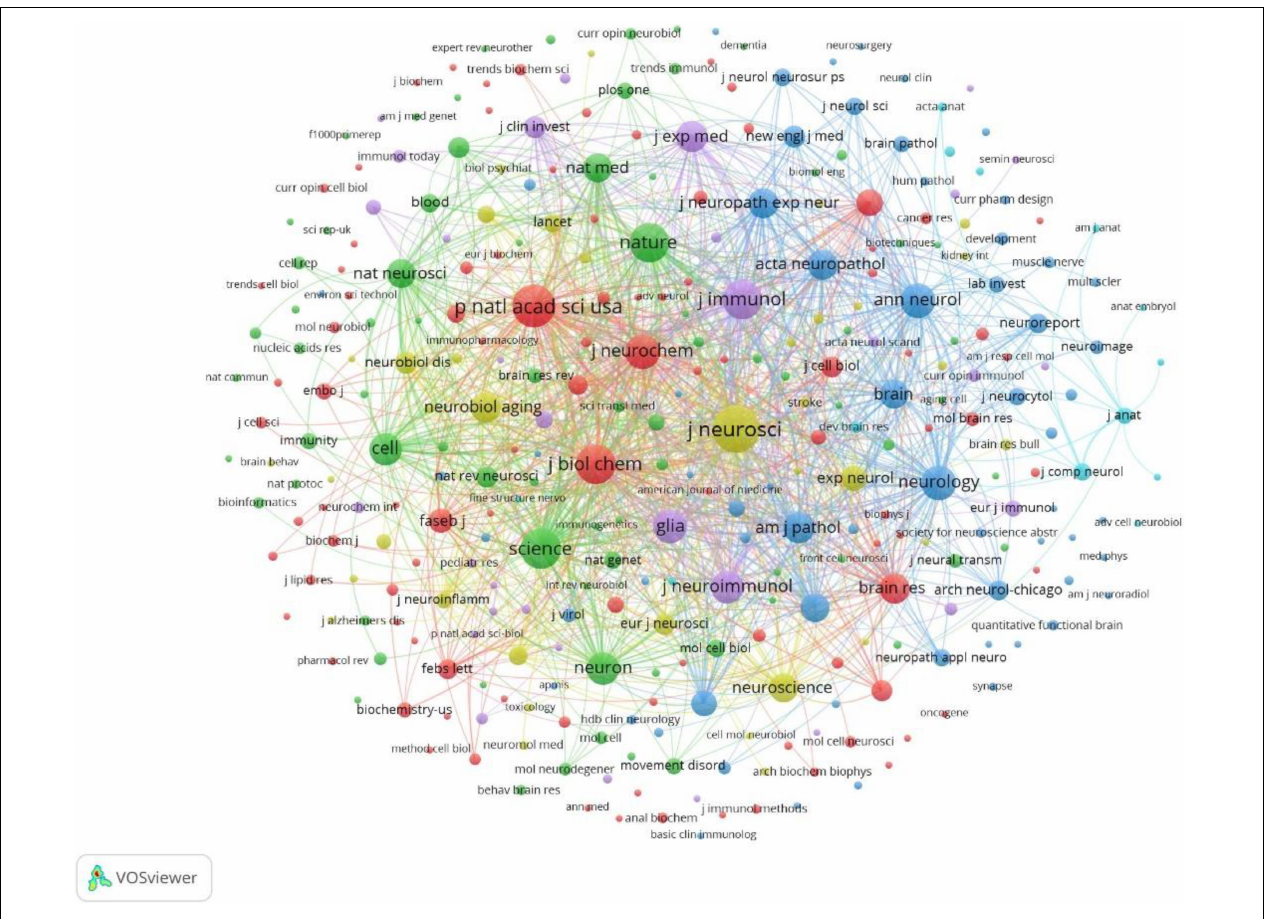
FIGURE 10 | Co-citation analysis of most frequently cited journals in the reference lists, weighed by citations, visualized map.